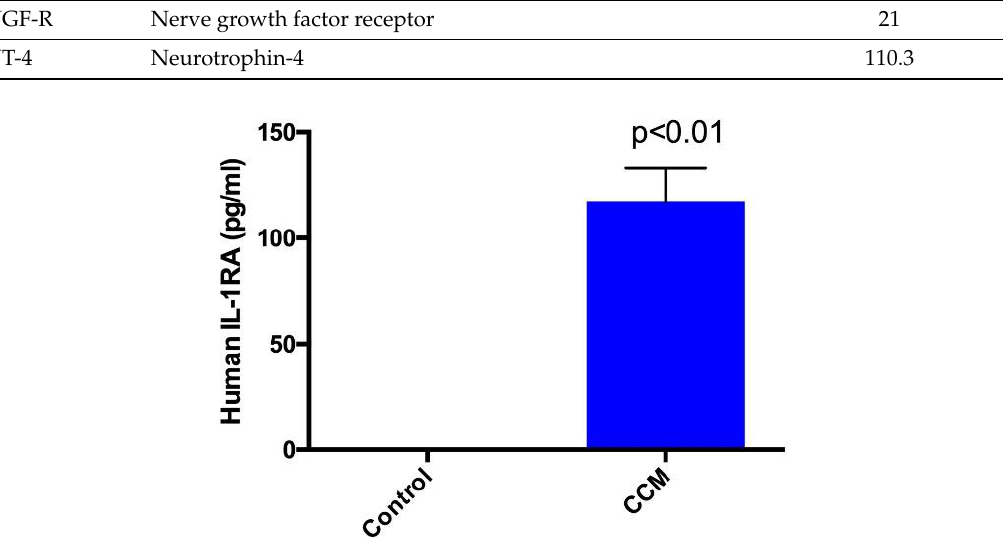
Figure 1. ELISA assay to determine the presence of human IL-IRA in control (media only) and cell-free stem cell-derived extract (CCM). Significantly high levels ( p < 0.01) of IL-1RA identified in CCM compared to no detectable IL-1RA in control. Data represent mean + SEM. CCM was produced in two lots in duplicate from two vials and ELISA for IL-1RA was performed using CCM from each lot three separate times in triplicate.